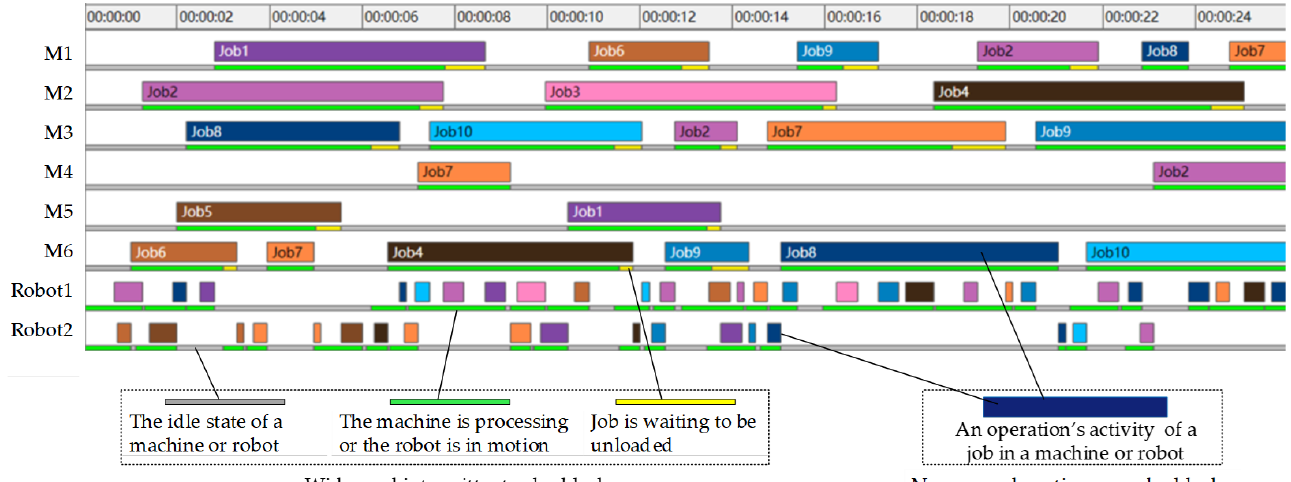
Figure 9. Gantt chart of real-time scheduling of FJSP-DP (MK01).